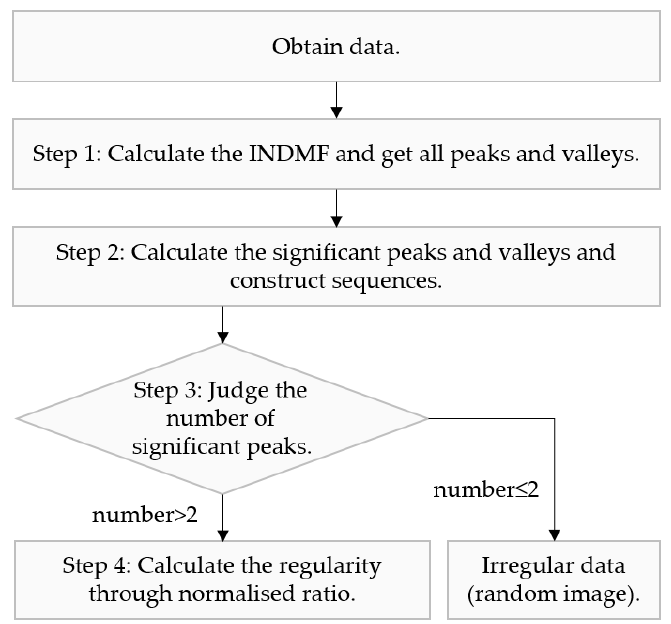
Figure 3. The flow chart of the INDMF regularity calculation